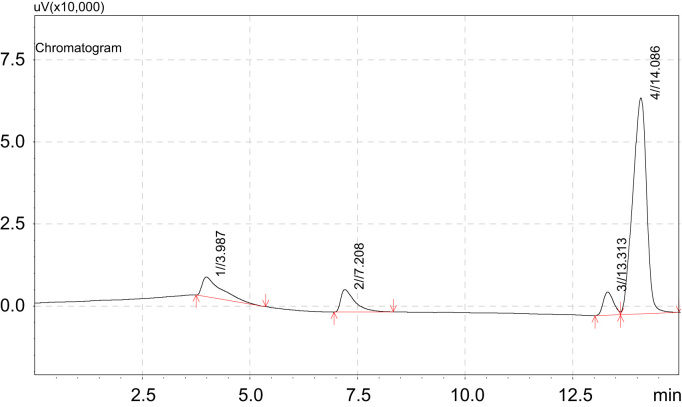
Sample standard.